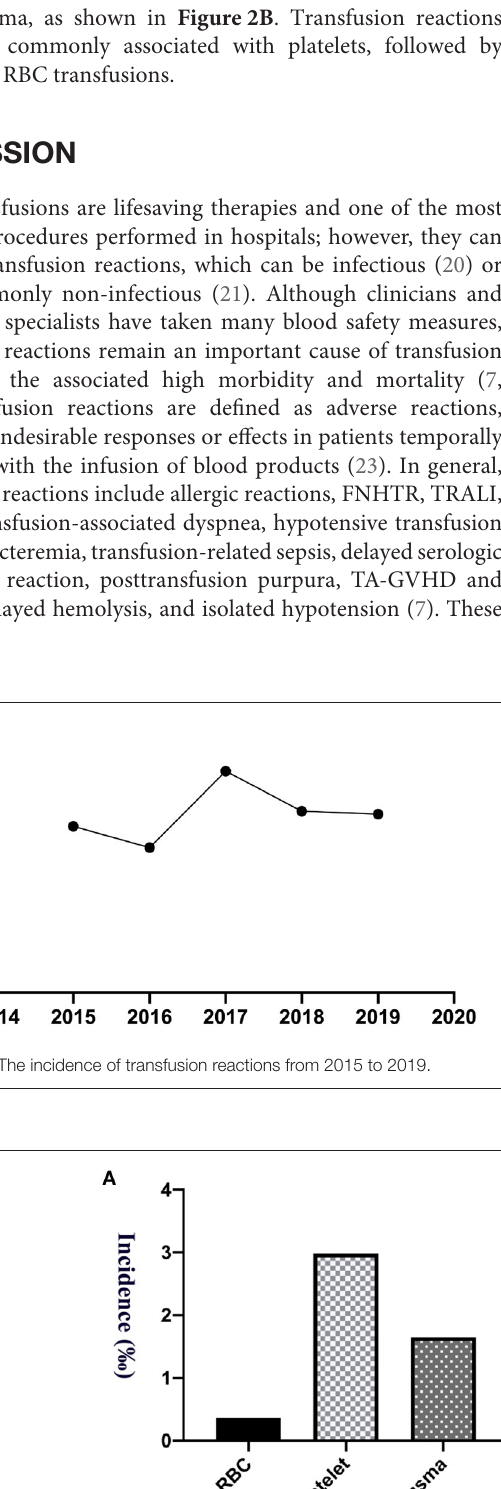
Frontiers in Pediatrics |